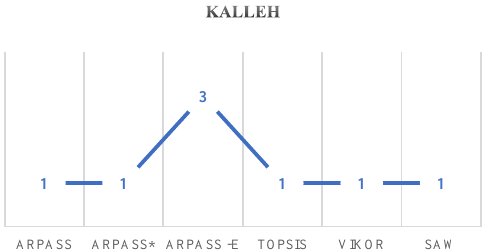
Figure 10. Rank fluctuation of Kalleh in the investigated MCDM methods.